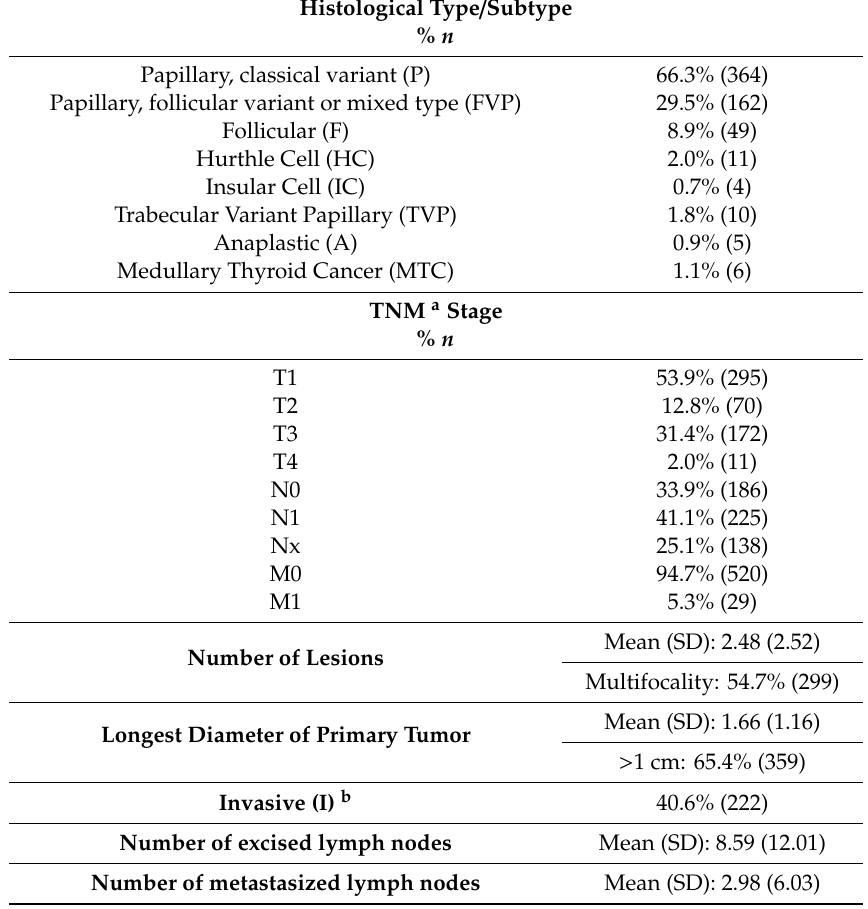
Table 1. Histopathological